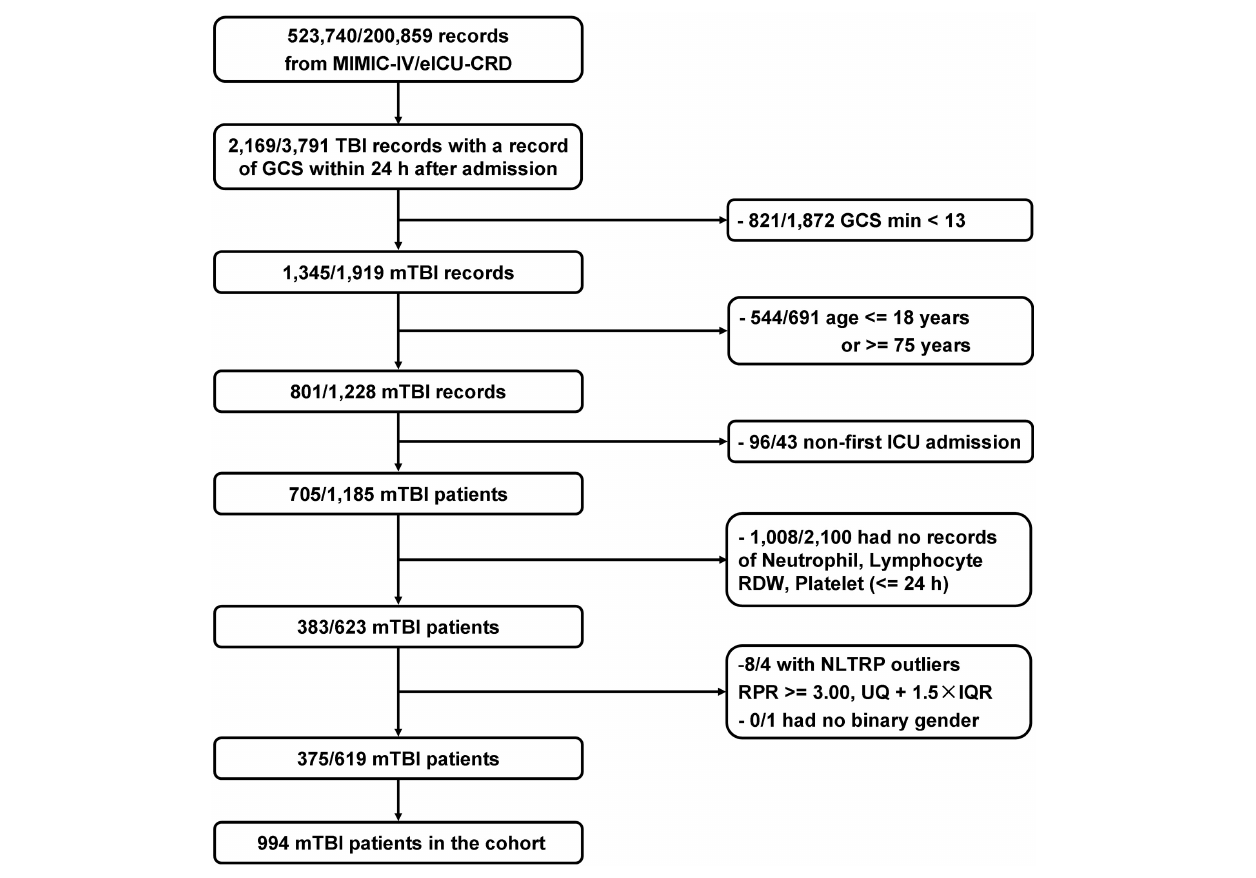
FIGURE 1 | Flowchart of the study population. In total, 994 patients who met the selection criteria were enrolled. GCS, Glasgow Coma Scale; IQR, interquartile range; mTBI, mild traumatic brain injury; NLTRP, neutrophil-to-lymphocyte ratio times red cell distribution width-to-platelet ratio; RDW, red cell distribution width; UQ, upper